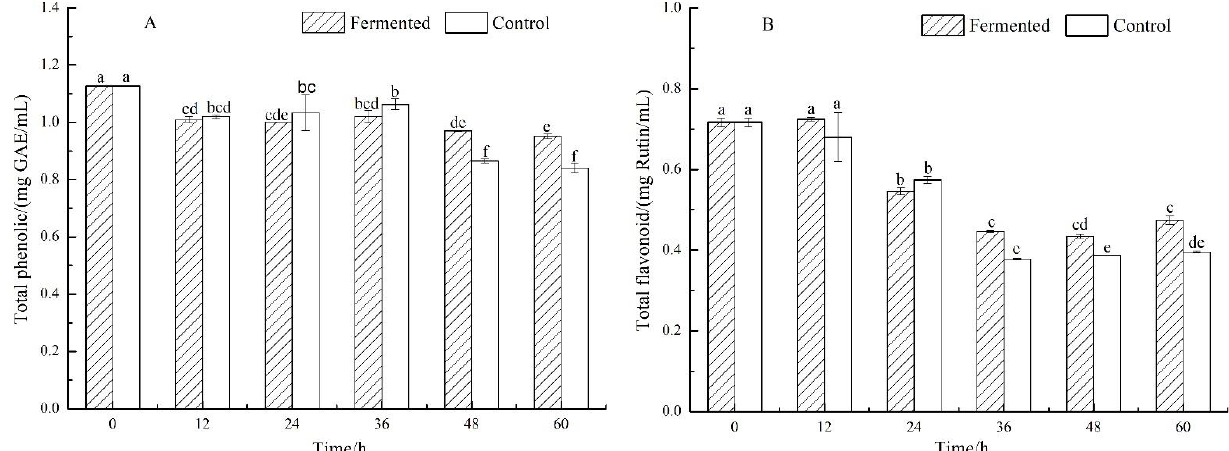
Figure 1. Total phenolic ( A ) and total flavonoid ( B ) contents of fermented and control lemon juice. Bars marked with different superscript lowercase letters ( a – f ) within the different periods (0 h – 60 h) indicate the significant difference ( p < 0.05) between fermented and control.